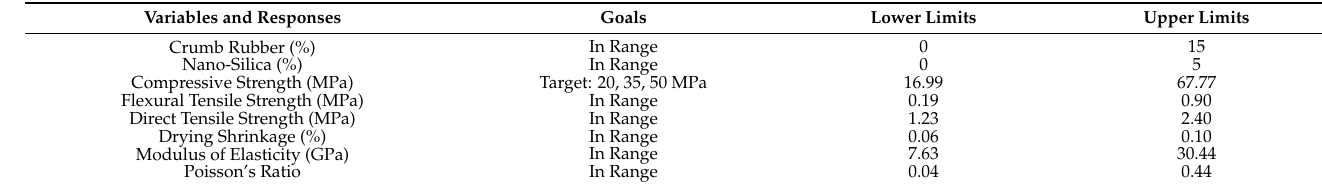
Table 10. Multi-objective optimization criteria.